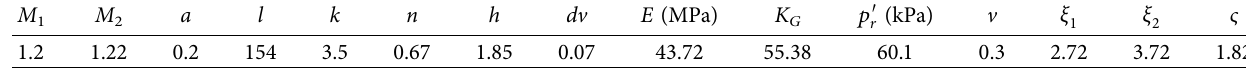
Table 1: The parameters for Tianjin Coastal clay.